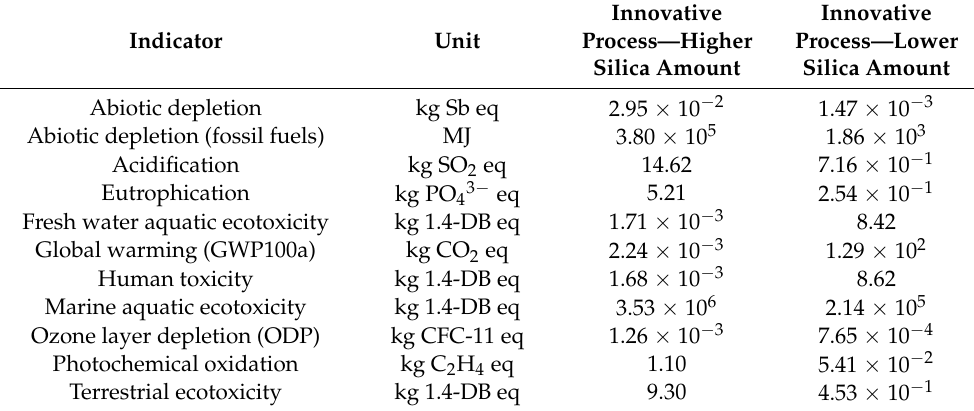
Table 4. Potential environmental impacts of innovative process vs. silica amount.